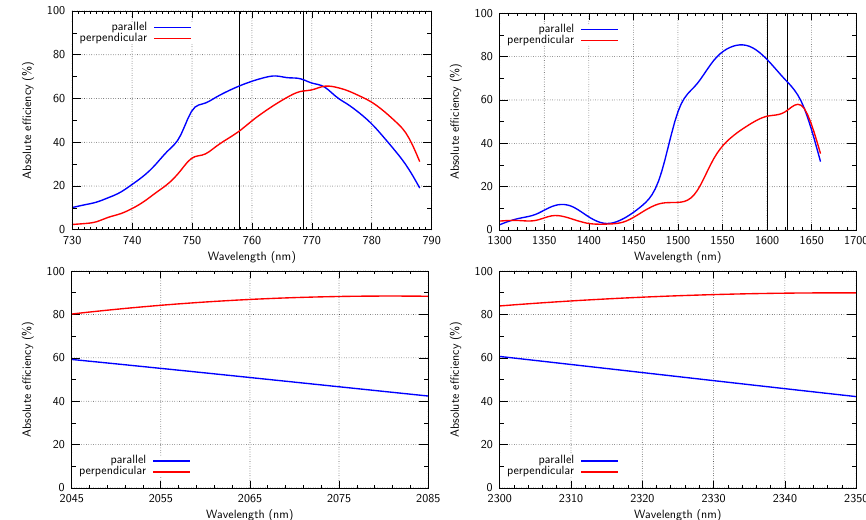
Figure 4. Absolute efficiencies of the gratings, measured in the O 2 A-band and weak CO 2 band, and predicted in the strong CO 2 band and CO band. There are two gratings, each used in two orders of diffraction to serve two bands. The vertical lines define the O 2 A-band and CO 2 weak band.